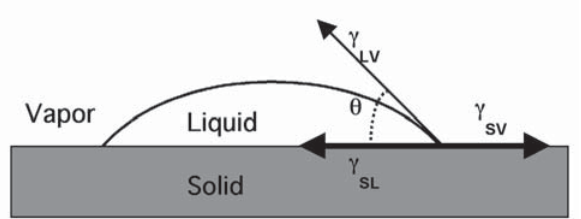
FIGURE 5- Schematic illustration of a liquid drop on a solid surface with energy vectors and contact angle ( θ ) as described by the equations 1-3. From Della Bona, et al. 29 ,